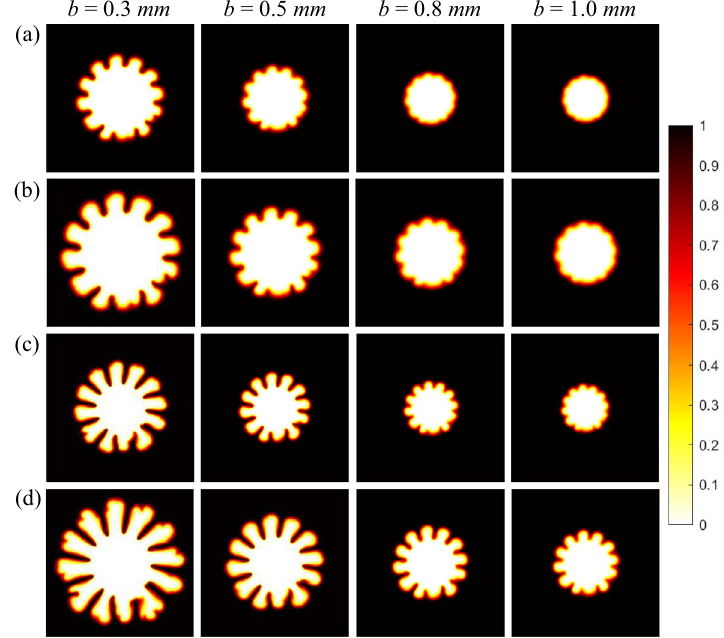
Figure 5. Density plots of the concentration c at different gaps, ( a ) M = 2 , U = 5 mm/s , ( b ) M = 2 , U = 10 mm/s , ( c ) M = 3 , U = 5 mm/s and ( d ) M = 3 , U = 10 mm/s at t = 15 s.